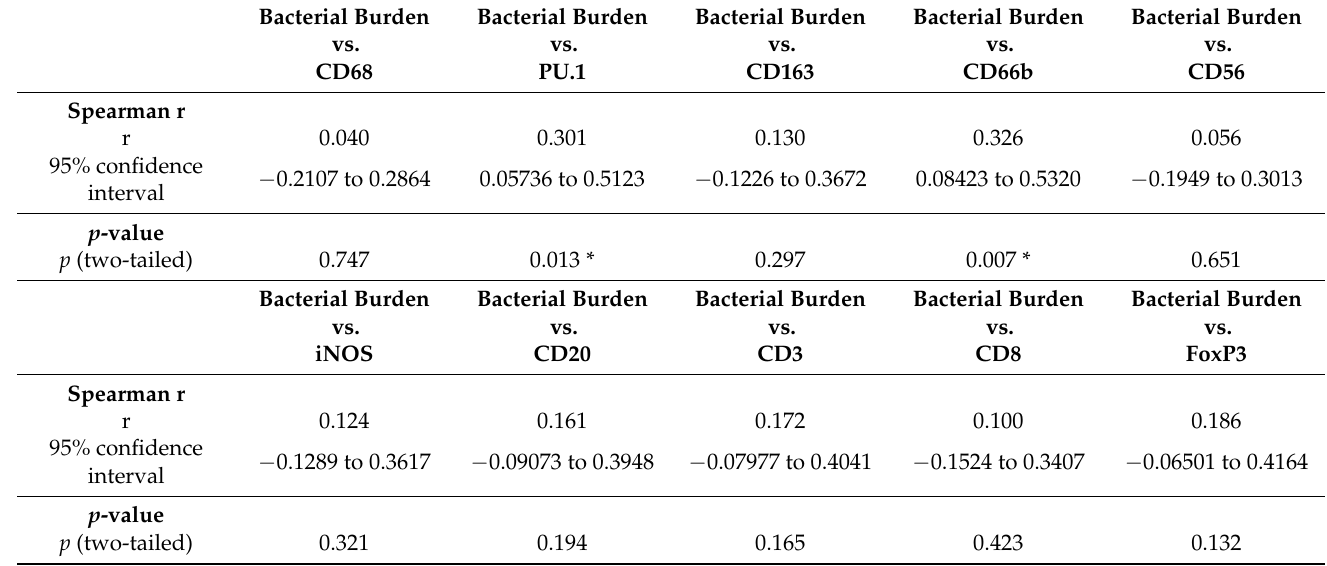
Bacterial Burden vs. CD56